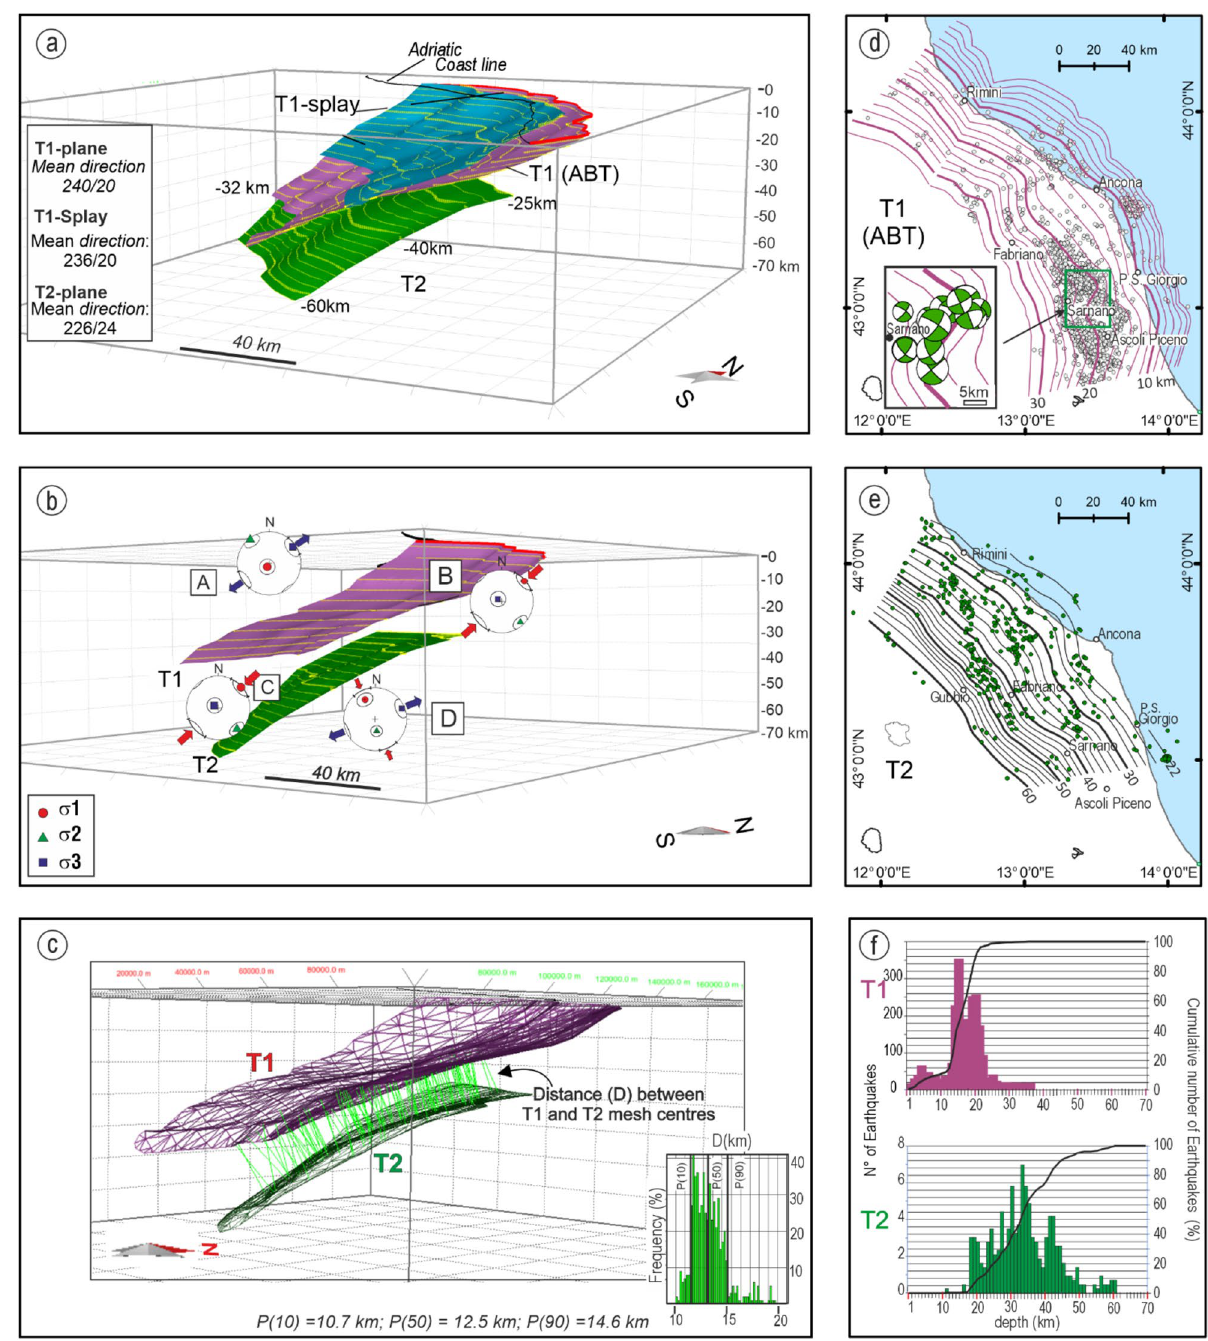
Figure 6. 3D Fault model of the Adriatic Basal Thrust (T1), its regional splay (T1-splay), and the underlying hidden thrust (T2). ( a ) Fault surfaces built with the MOVE Suite software v. 2020.1 (Petroleum Experts Ltd), view from SE. ( b ) Fault model view from south and stereonet representation of the coexisting stress regimes at different crustal depths (A = upper to mid-crust tension; B = upper crust compression; C = lower crust compression, D = lower crust strike-slip). ( c ) distance between T1 and T2 measured with the Similar Construction Method of the MOVE Suite software v. 2020.1 (Petroleum Experts Ltd) tool; the histogram in the lower right corner represents the distance distribution between T1 and T2. ( d , e ) depth contour lines of T1 and T2, spaced 2.5 km along the depth, with the epicentral distribution of the events extracted from the EQS-catalog and associated with T1 and T1-splay (white dots) and T2 (green dots); ( f ) depth distribution of earthquakes associated with T1 and T2 from the